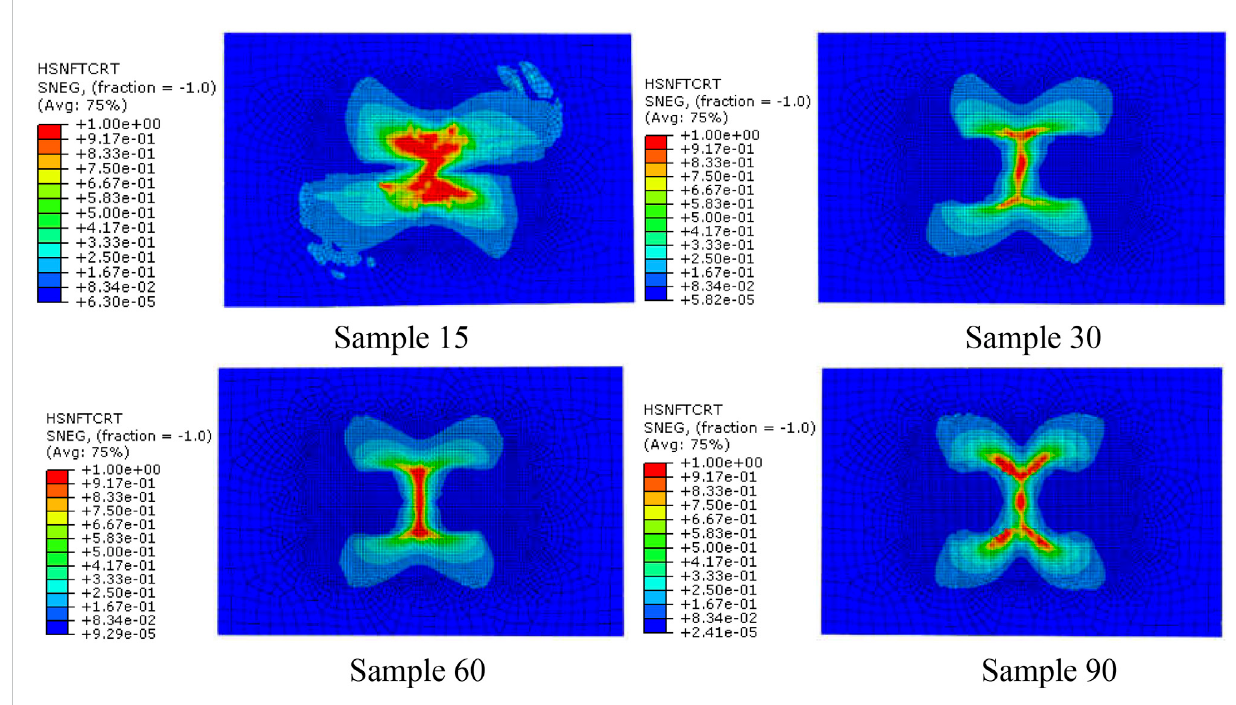
FIGURE 10 The fi ber tensile failure distribution when the impact energy is 20 J.